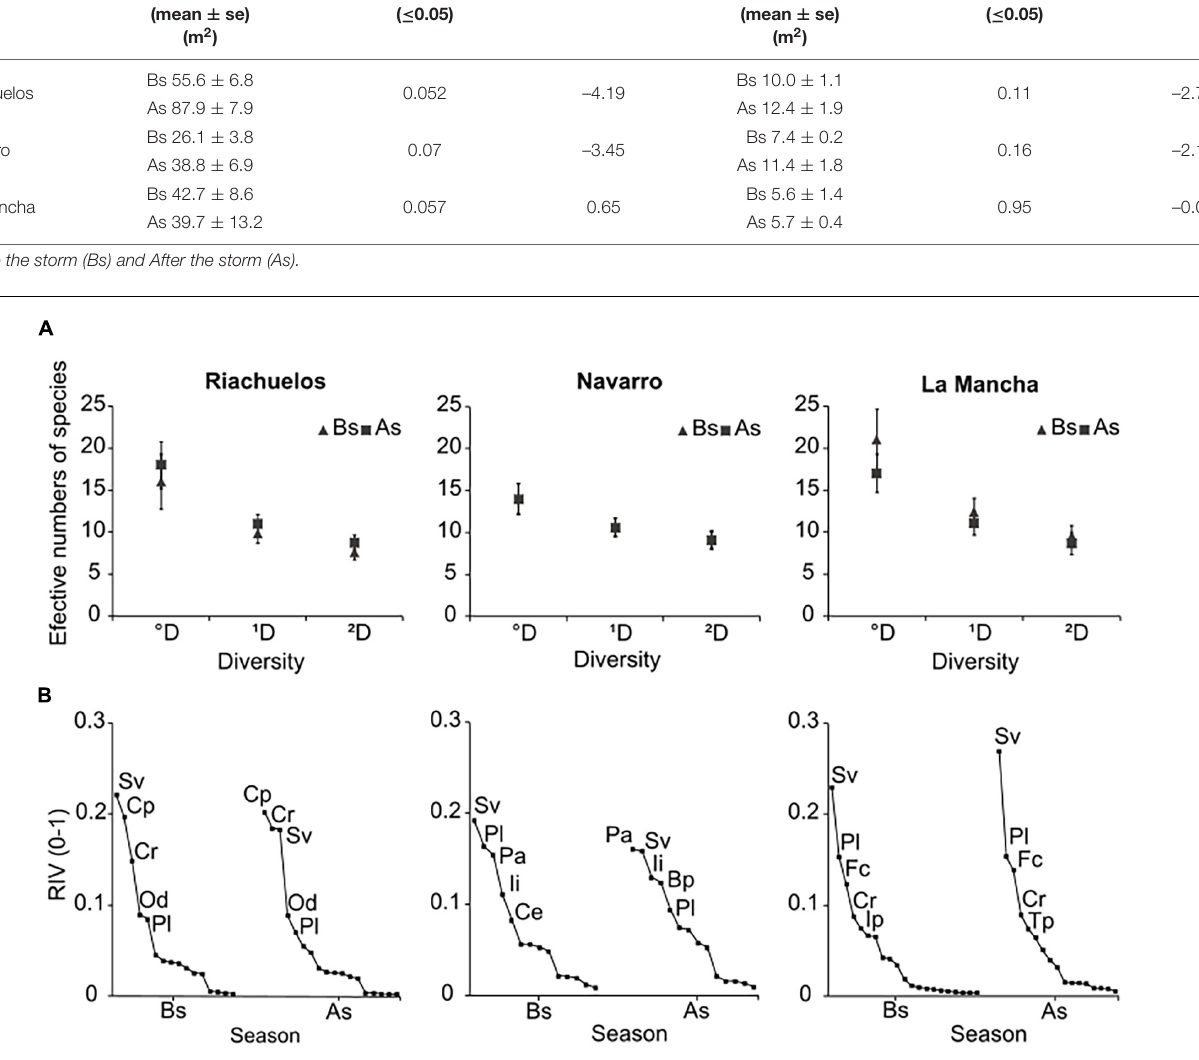
FIGURE 9 | (A) Plant diversity on the three beaches before (Bs) and after the storm (As). Species richness ( 0 D), the number of common species ( 1 D), and the dominant species ( 2 D) in the community were evaluated. Error bars correspond to the 95% CI. (B) Relative Importance Value (RIV) on the three beaches before (Bs) and after the storm (As). Only the five most dominant species on each beach are shown. Letters next to the point denote the name of the species: Sv ( Sporobolus virginicus ), Cp ( Croton punctatus ), Cr ( Canavalia rosea ), Od ( Oenothera drummondii ), Pl ( Palafoxia lindenii ), Pa ( Panicum marum ), Ii ( Ipomoea imperati ), Ce ( Cenchrus echinatus ), Bp ( Bidens pilosa ), Fc ( Fimbristylis cymosa ), Ip ( Ipomoea pes-caprae ), and Tp ( Trachypogon plumosus